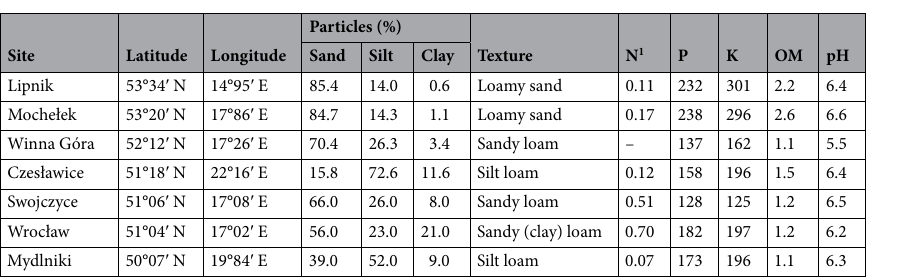
Table 7. Coordinates and soil characteristics of the study sites. 1 N nitrogen (%), P phosphorus (mg kg −1 ), K potassium (mg kg −1 ), OM organic matter (%).